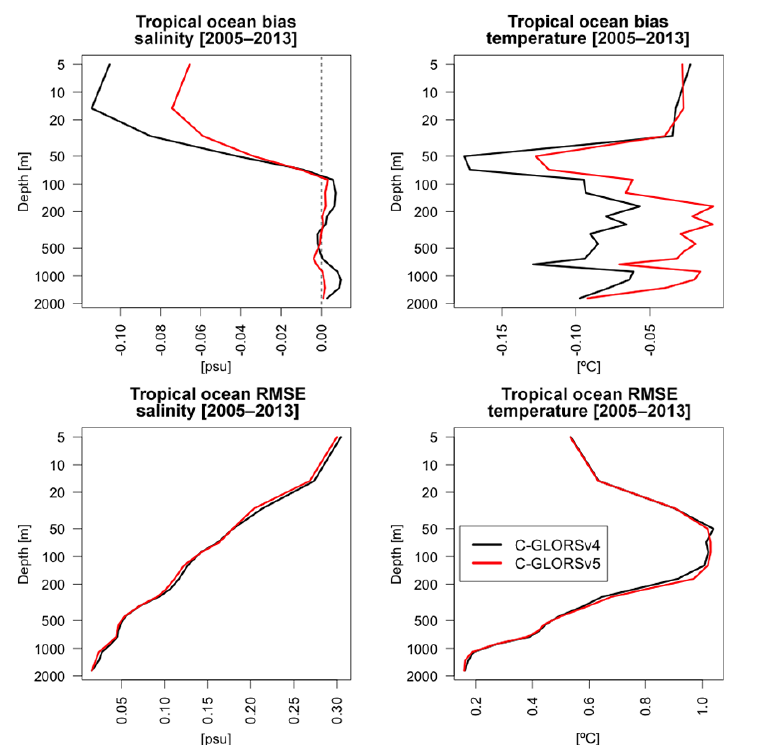
Figure 6. As Fig. 5, but for the tropical ocean skill scores (between 30 ◦ S and 30 ◦ N).